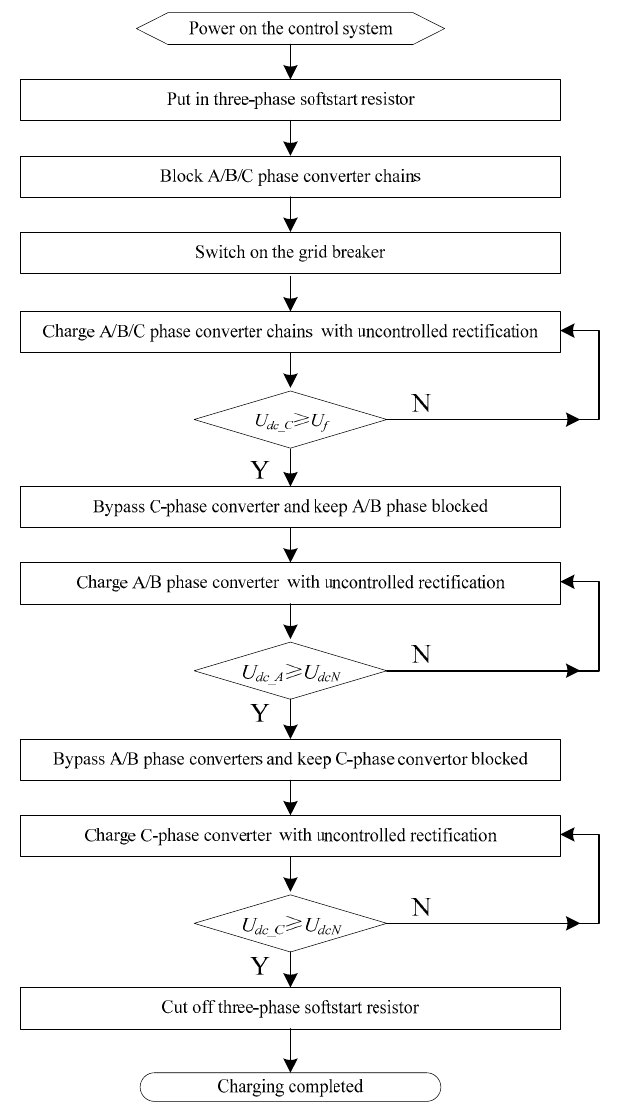
Figure 6. The flow diagram of soft power-on process for the individual phase full-load testing system.